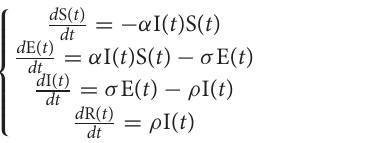
Figure 2 is a schematic diagram of the classic SEIR model: SEIR model uses fixed probability to describe the individual